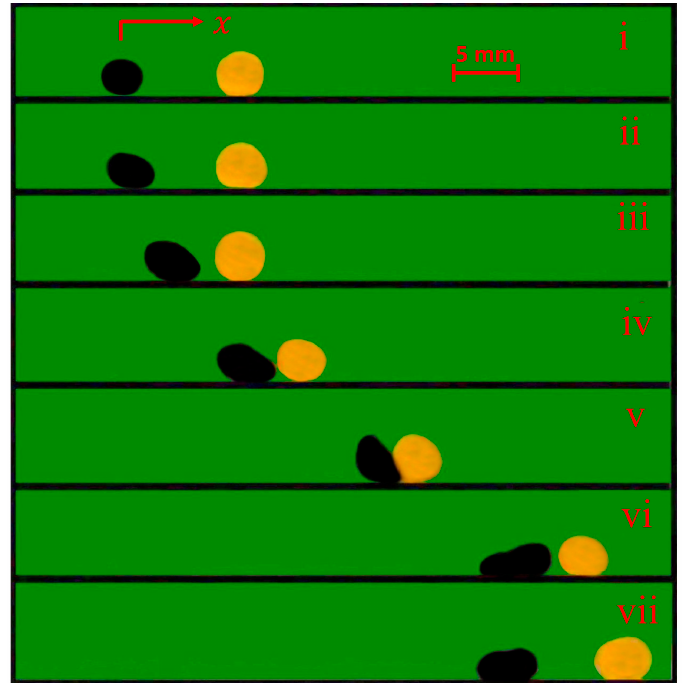
Figure 4. The process of launching a WLM with an FLM with volumes of 30 µ L, initial distances from